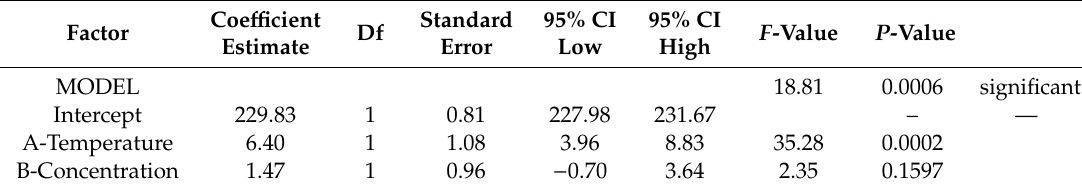
Table 3. Linear model regression coe ffi cients statistical analysis.